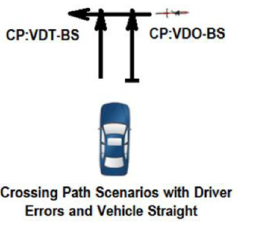
Figure 5 Crash geometry of CP:VDO scenarios